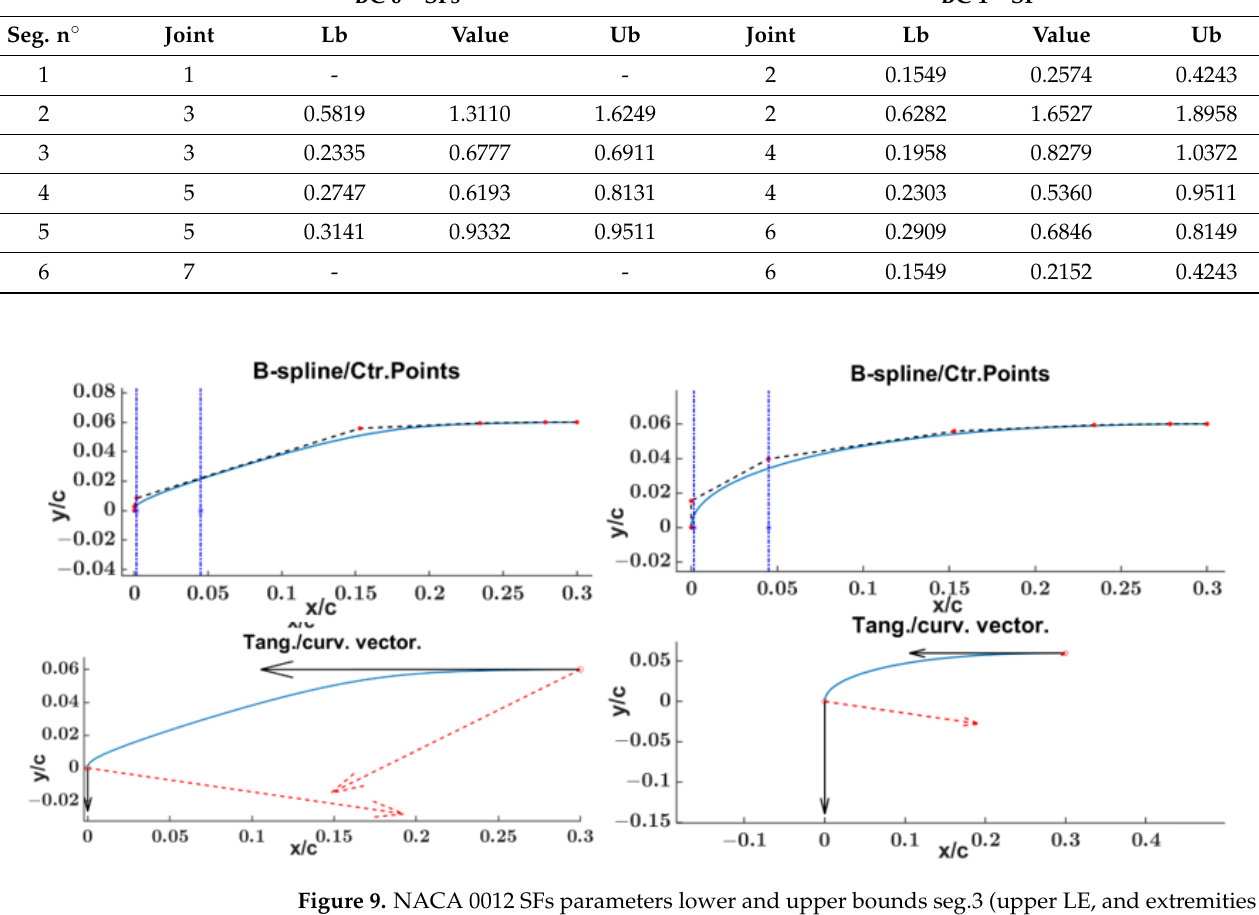
Figure 9. NACA 0012 SFs parameters lower and upper bounds seg.3 (upper LE, and extremities C ’ (black color), C ’’(red color) vectors.